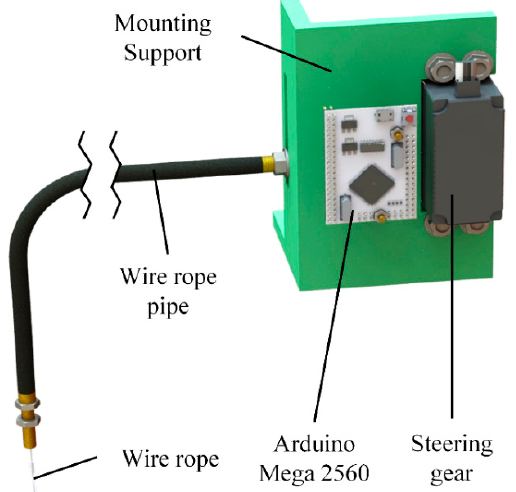
Figure 8. Rope drive mechanism.